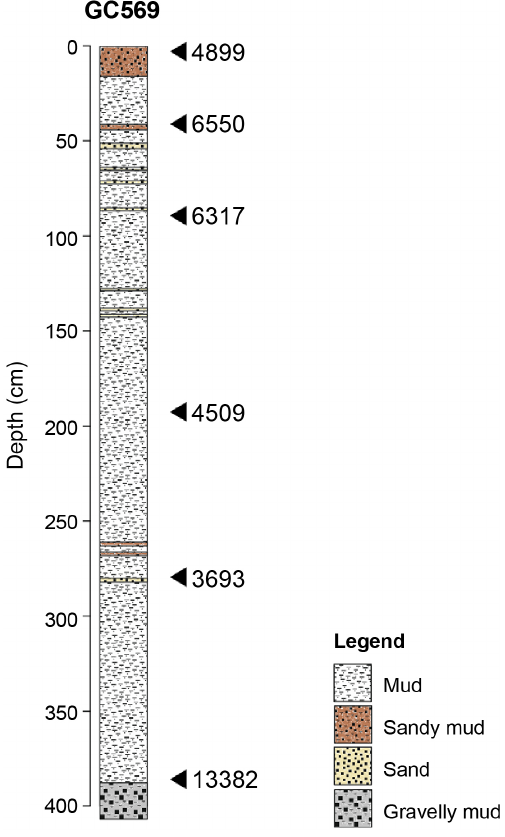
Figure 6. Sediment core log for GC569, a 4.08m long gravity core from the deep basin in Albert Trough (see Fig. 3c for location). The core consists of stiff, greenish-grey gravelly mud and clasts below 3.88m, overlain by laminated diatomaceous muds and oozes with occasional sand layers. The latter indicate open water marine sedimentation over the site or possibly advection of nearby diatom blooms under an ice